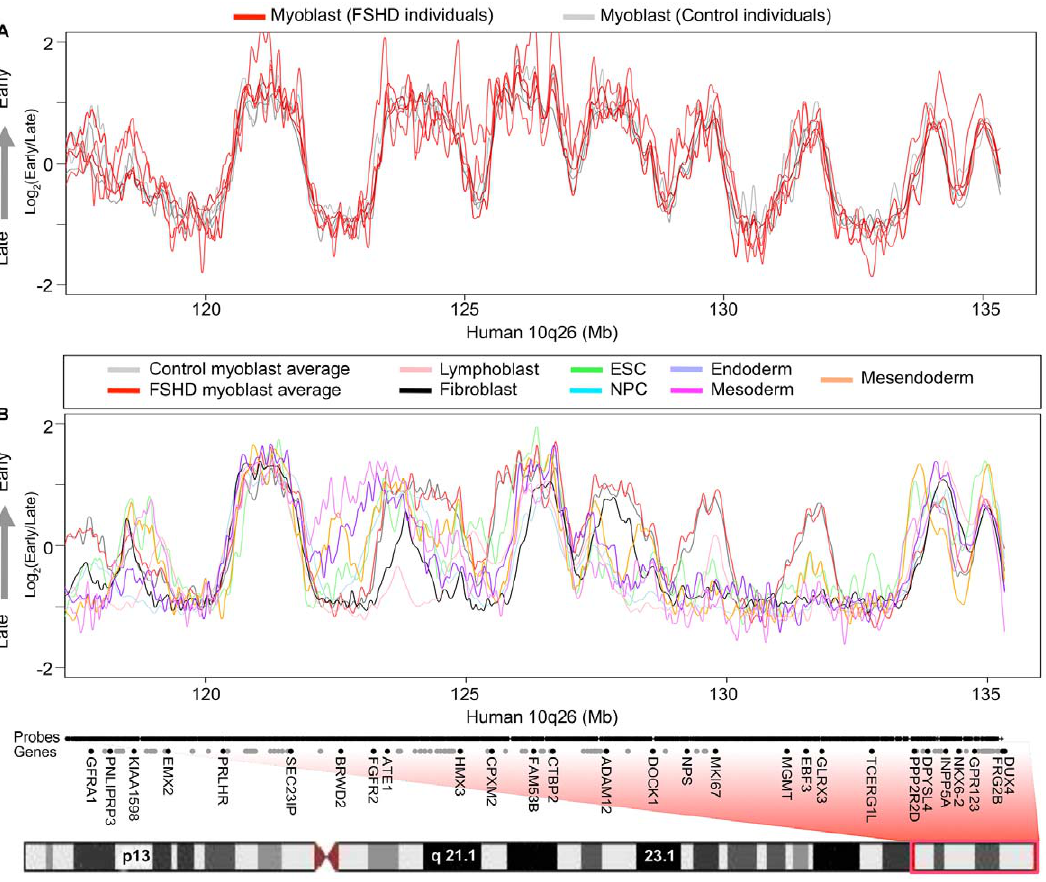
Figure 4. D4Z4 contraction and FSHD disease background do not affect 10q26 replication timing. (A) Primary human myoblast replication timing profiles are shown for 3 control (gray) individuals and 4 FSHD (red) patients across the proximal region to 10q26. One FSHD dataset (FM7) had a low signal to noise ratio and deviates somewhat from other datasets, but was still included for comparison. (B) Replication timing profiles for many different human cell types are shown across the proximal region to 10q26. Boxed in red is the region of human chromosome 10 corresponding to 10q26. Microarray probe positions are indicated along the X-axis by short black vertical lines. Genes are indicated by black dots, for those whose name is given, or gray dots, for those with too high a density to add a label. DUX4 transcripts derived from 10q26.3 D4Z4 map between hg18 chromosome 10 coordinates 135,330,358 and 135,338,574 (UCSC Genome Browser, http://genome.ucsc.edu/).